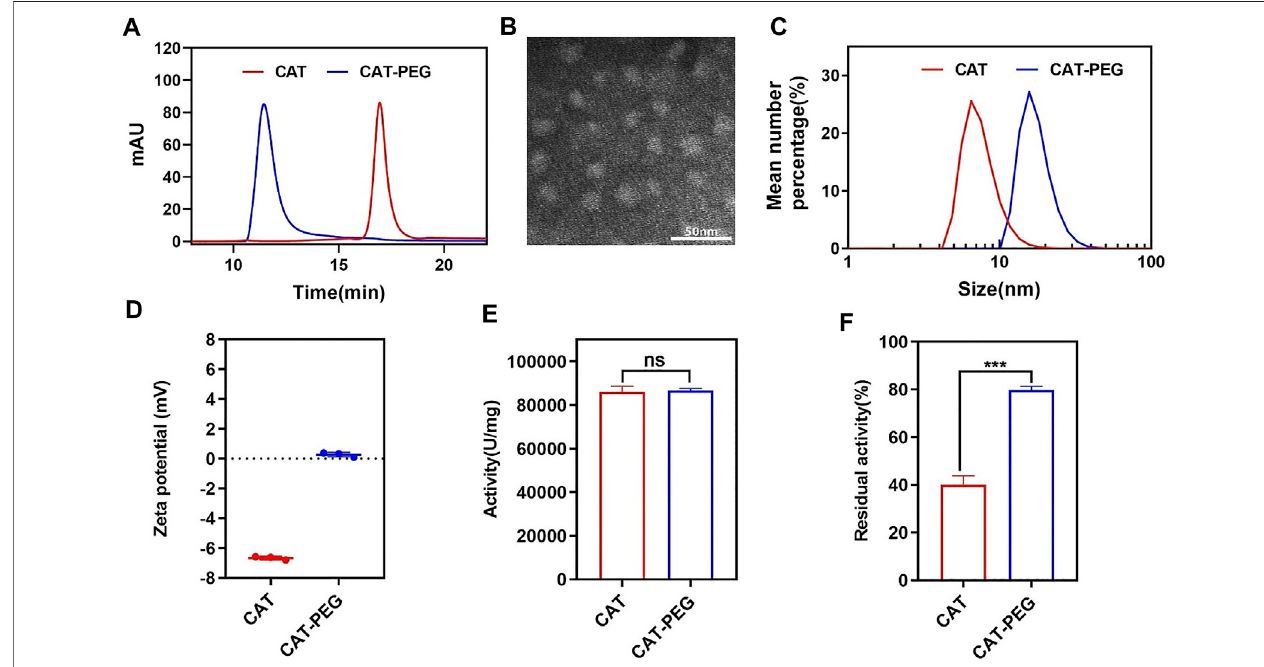
FIGURE 1 | Characteristics of CAT and CAT-PEG. (A) HPLC of CAT and CAT-PEG; (B) TEM image of CAT-PEG; (C) DLS and (D) zeta potential of CAT and CAT- PEG; (E) The enzyme activity and (F) proteolytic stability of CAT and CAT-PEG. n (cid:2) 3. Data represent means ± s.e.m. *** p ＜ 0.001. ns means not signi fi cant.